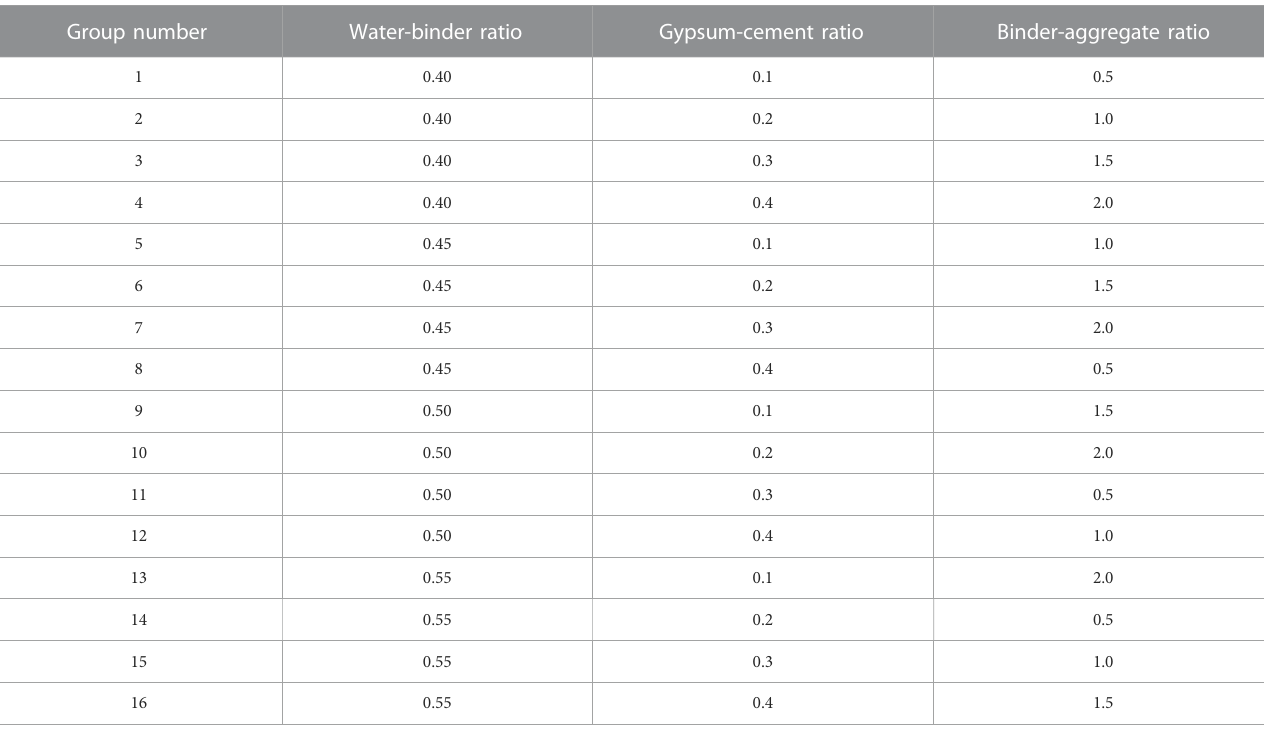
TABLE 2 Orthogonal design combination of class 2 sandstone materials. Group